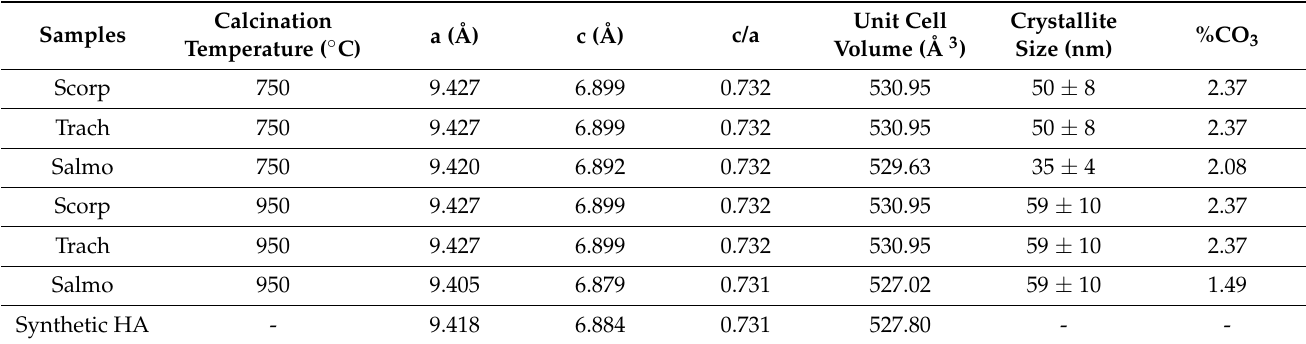
Table 5. Cell parameters, unit cell volume, crystallite size and carbonate content of powders obtained from fish bones at different calcination